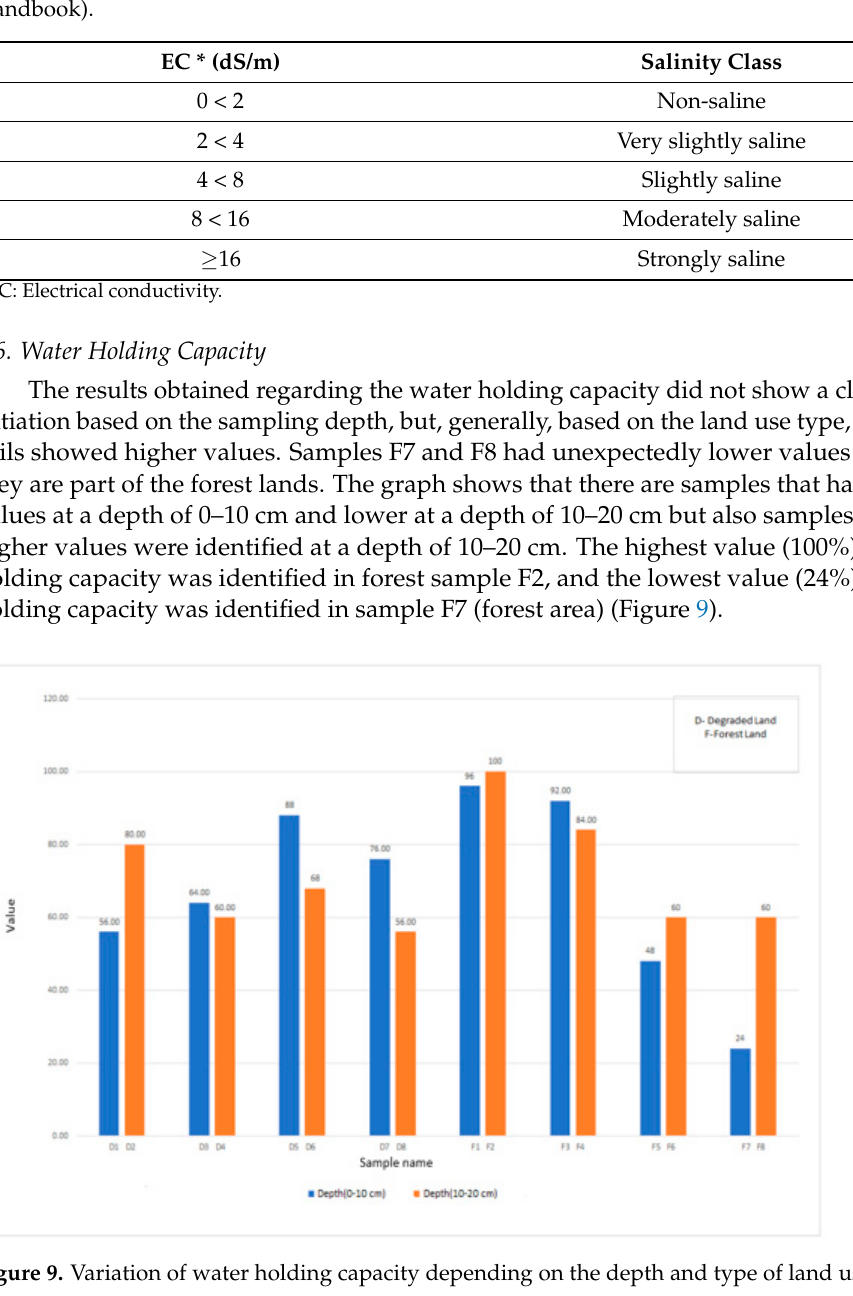
Figure 9. Variation of water holding capacity depending on the depth and type of land use.